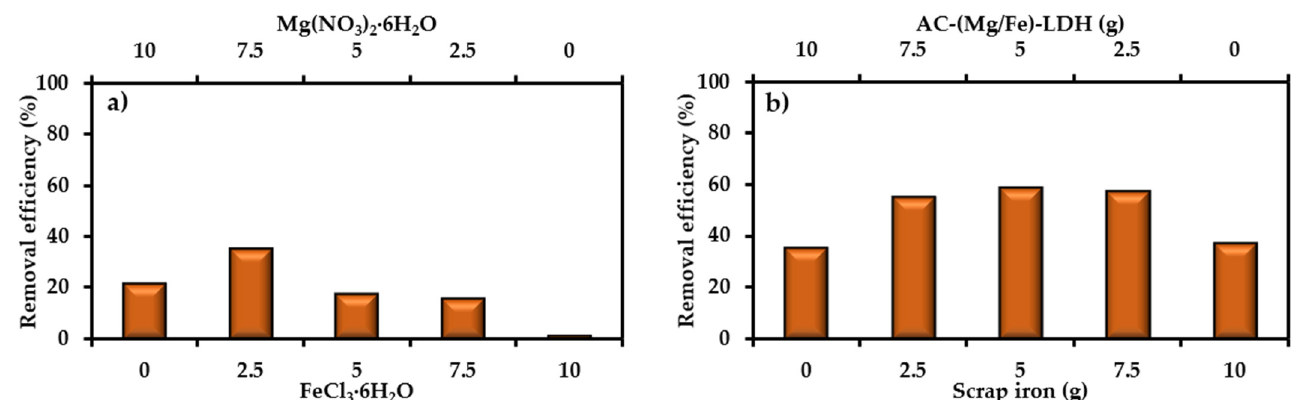
Figure 1. Removal efficiency of SO 42 − ions from contaminated water onto ( a ) AC-(Mg/Fe)-LDH for different weight ratios of Mg(NO 3 ) 2 ·6H 2 O and FeCl 3 ·6H 2 O and ( b ) mixture of AC-(Mg/Fe)-LDH and scrap iron.